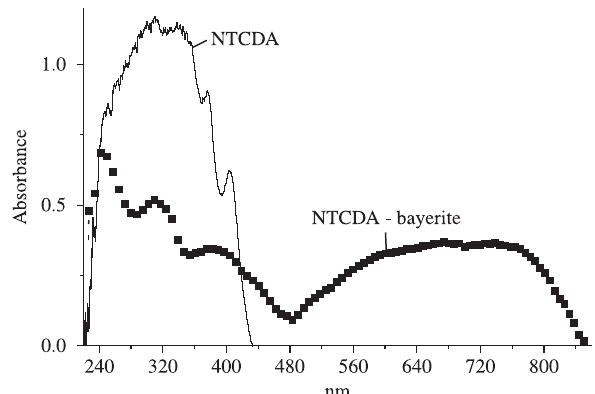
Figure 6. UV-VIS spectra of the pure NTCDA powder and NTCDA-bayerite powder recorded by diffuse reflectance.